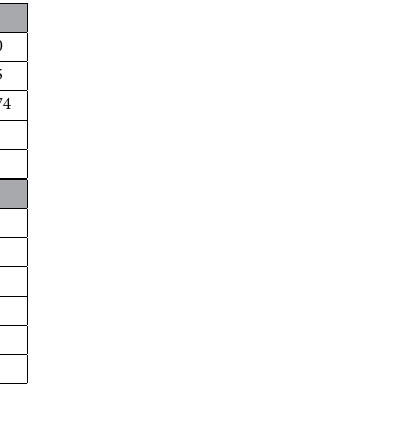
Table 6. Results of the selective collection of